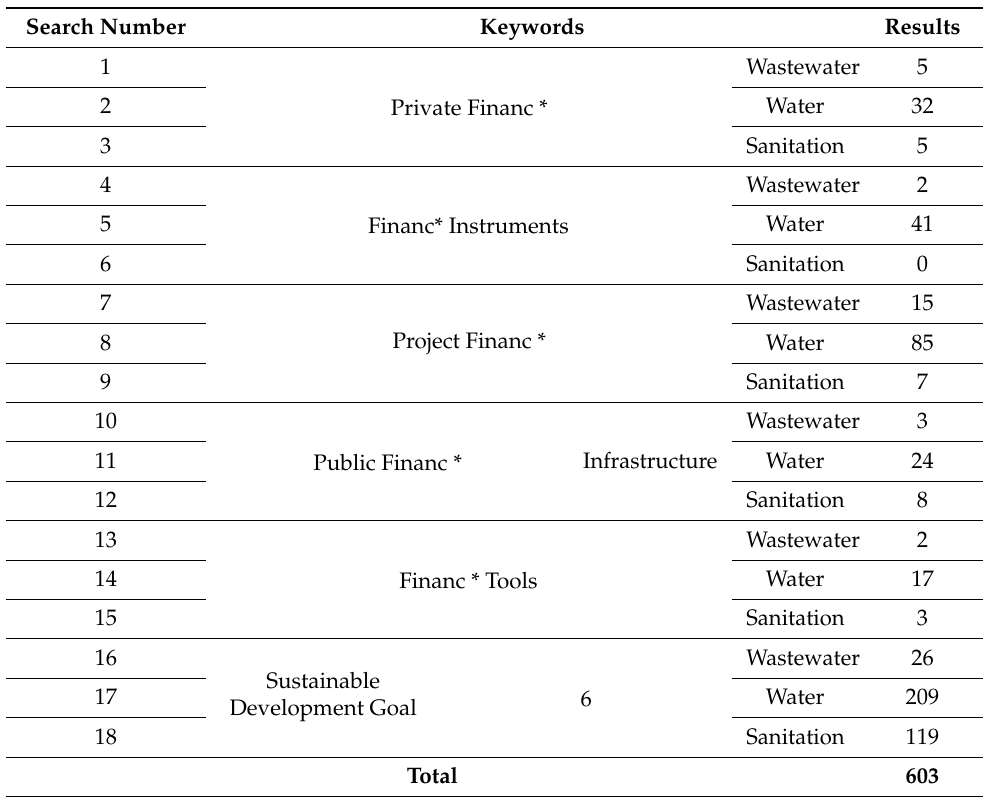
Table 1. Results from Scopus